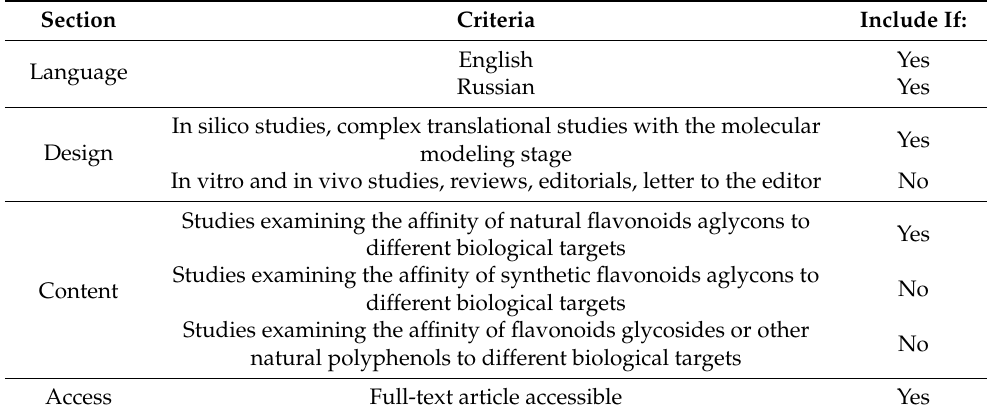
Table 1. Overall inclusion and exclusion criteria for publication screening.